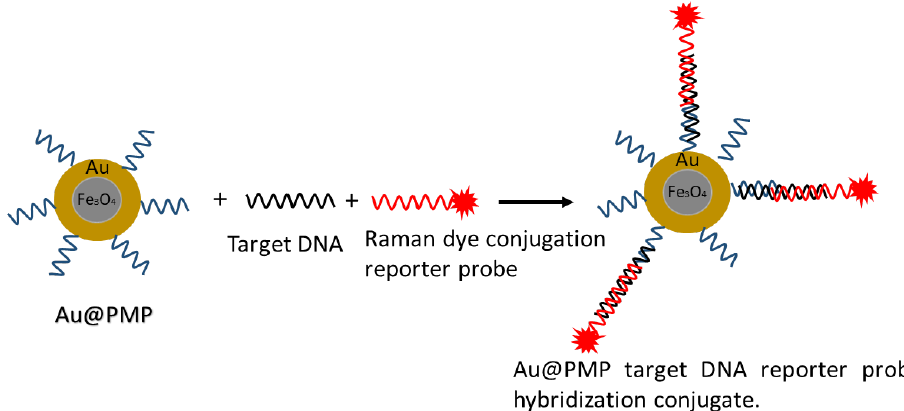
Figure 5. Antisense oligonucleotide for the direct detection of the viral genome from the gold nanoparticles, ASO labeled with Raman active compound for the high specificity. Reproduced with permission [198]. Copyright © 2012 American Chemical